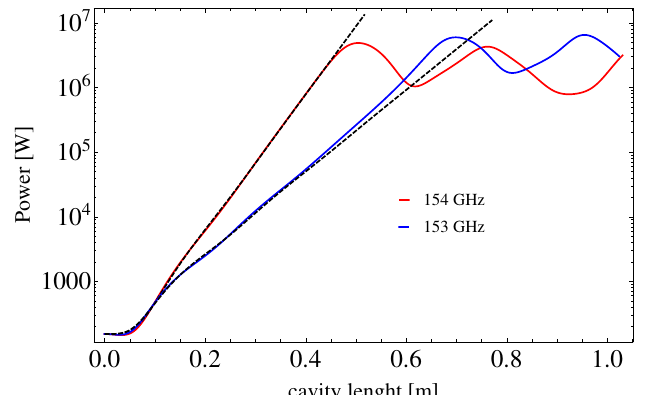
Figure 10. Analytical solution in SSA regime (dashed line) overlapped at the numerical solution (continuous line) obtained using the parameters in Table